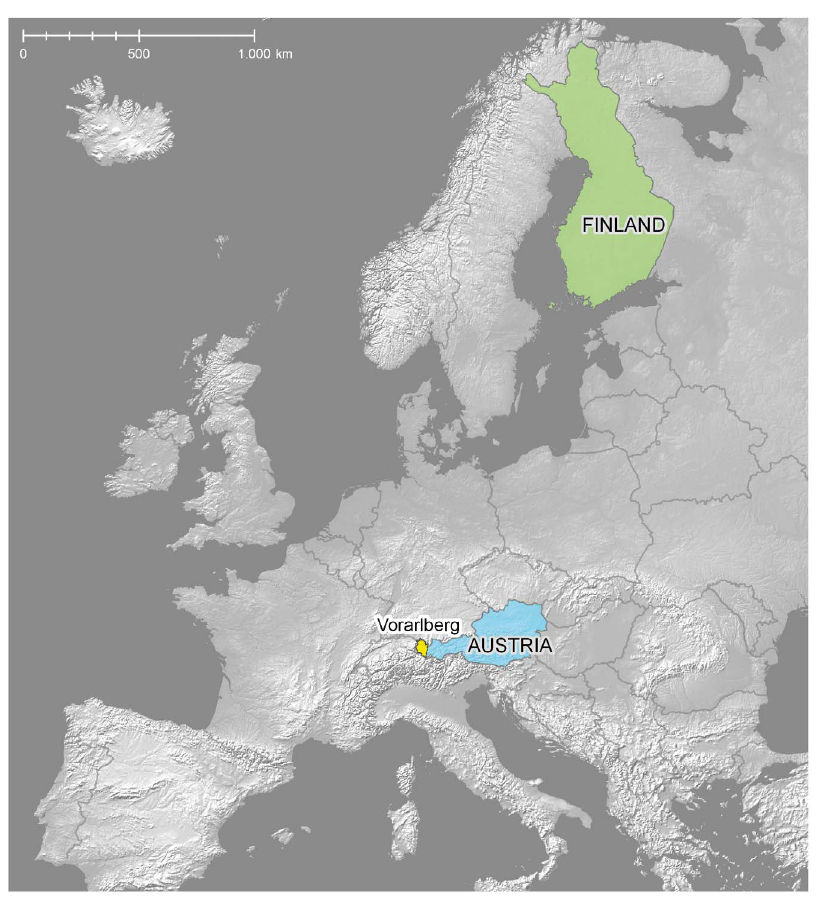
Fig. 1. Map showing study areas Finland and Austria/Vorarlberg. Digital base map from Natural Earth. Free vector and raster map data @ .